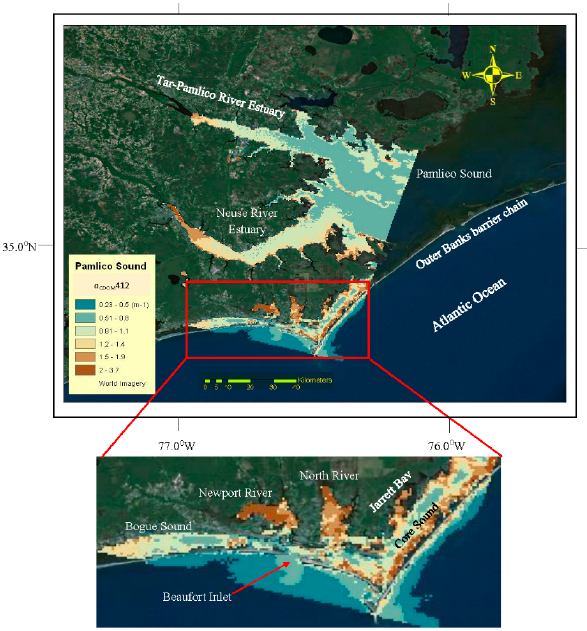
Figure 10. a CDOM 412 distribution in the Pamlico Sound (NC) estuary system and along the southern coast retrieved from a full resolution (300 m pixel) MERIS image (1 January 2008). Inset shows fine scale CDOM gradients in local rivers, Bogue Sound and Jarrett Bay. Note the plume of DOM leaving Beaufort